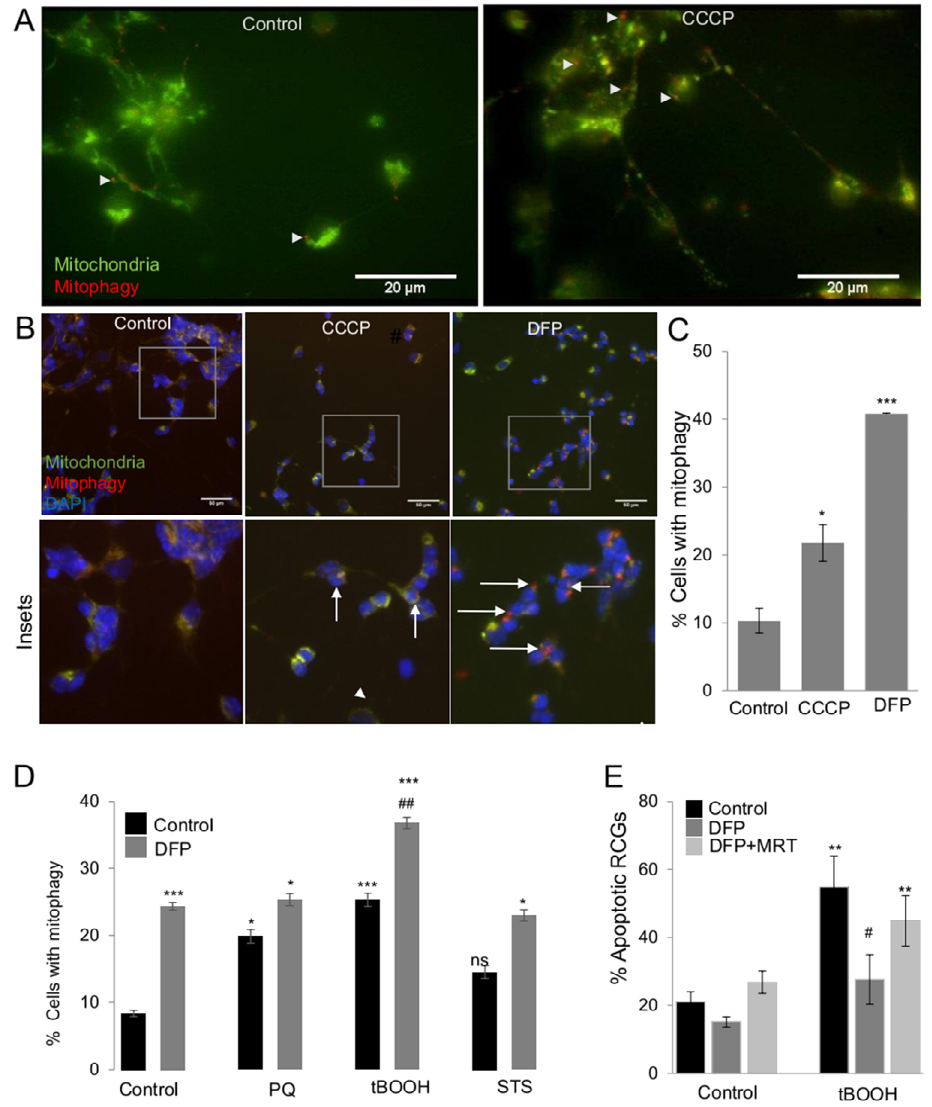
Figure 4. Mitophagy induction and rescue from oxidative stress in mito -QC primary RGCs. ( A ) Primary RGCs isolated from P0 mito -QC mice were incubated with CCCP at 10 µM for 3 h. Representative images in live RGCs, note the red-only puncta that are labeled with white arrows. Scale bar 20 µm. B. Primary RGCs isolated from P0 mito -QC mice were incubated for 24 h with 25 µM CCCP and 2.5 mM DFP. Representative epifluorescence images are shown in ( B ), where the red puncta indicative of mitophagy are depicted with white arrowheads. The quantification of the % of mitophagy positive cells is depicted in ( C ). ( D ) Primary RGCs isolated from P0 mice were treated for 24 h with 2 mM PQ, 200 µM tBOOH and 3.5 µM STS, in the presence or absence of 0.25 mM DFP for 24 h. After the incubation cells were fixed and stained with b-III-tubulin (TUJ1) and DAPI. The % of apoptotic RGCs was determined by counting TUJ1 positive cells with condensed apoptotic nuclei. The number of RGCs was counted in at least 8 fields of three different experiments. * p < 0.05 vs. control; *** p < 0.001 vs. control, # p < 0.05 vs. treatment, ## p < 0.01 vs. treatment. ( E ) Primary RGCs isolated from P0 mito -QC mice were incubated with 200 µM tBOOH in the presence or absence of 0.25 mM DFP and 1 µM MRT for 24 h. After the incubation cells were fixed and stained with b-III-tubulin (TUJ1) and DAPI. The % of apoptotic RGCs was determined by counting TUJ1 positive cells with condensed apoptotic nuclei. The number of RGCs was counted in triplicates in 4 fields per condition (>200 RGCs per condition) * p < 0.05 vs. control; ** p < 0.01 vs. control # p < 0.05 vs. treatment.